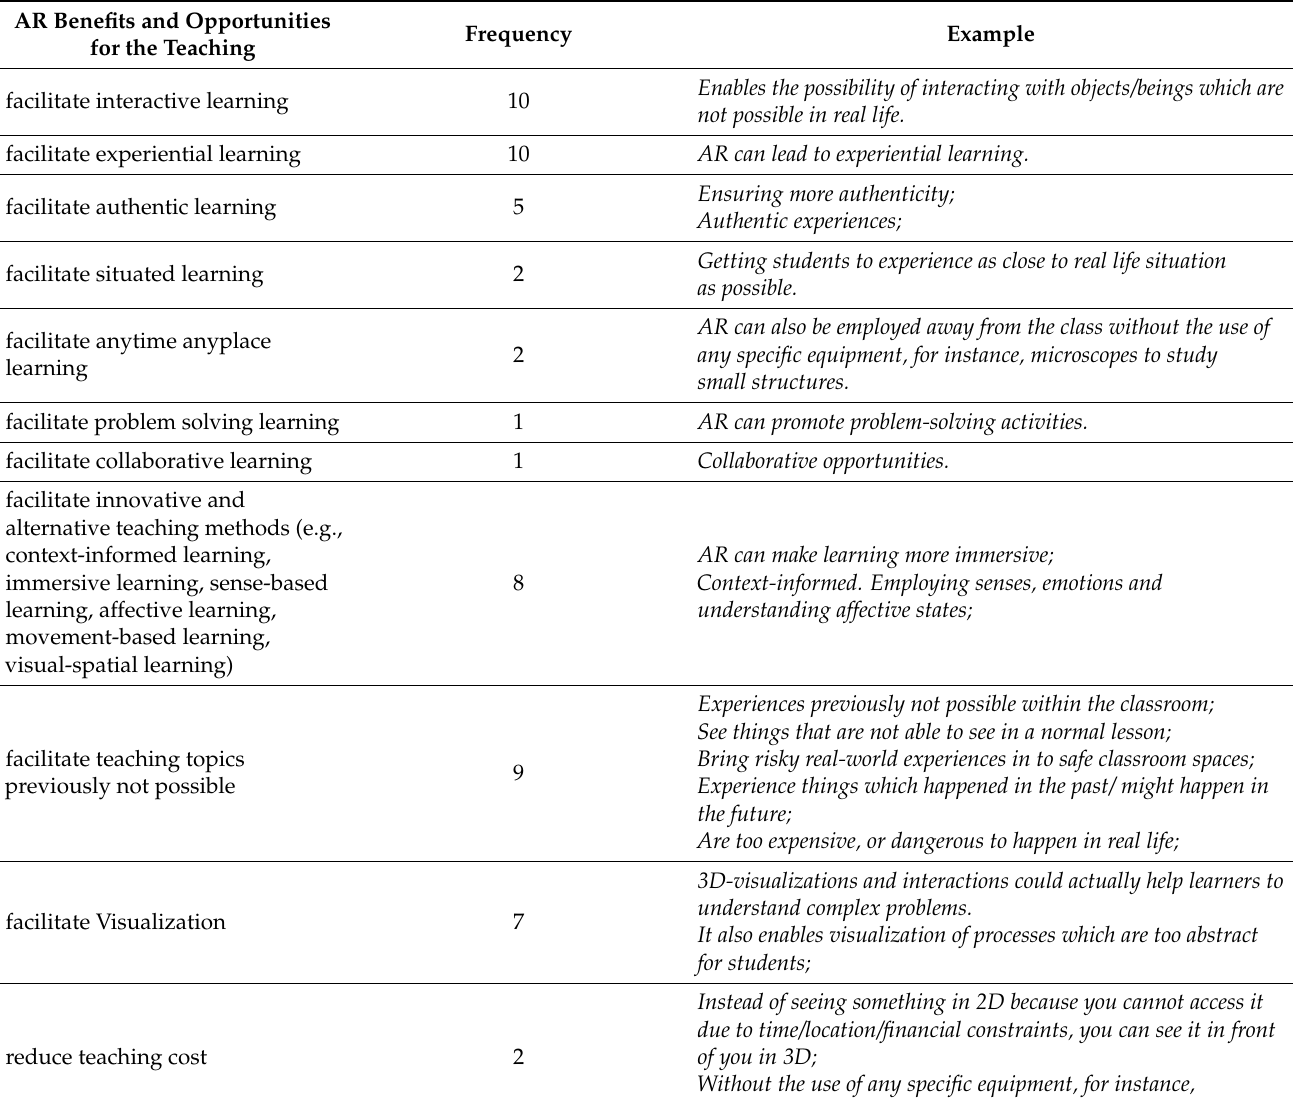
Table 11. Teaching’s benefits and opportunities of integrating